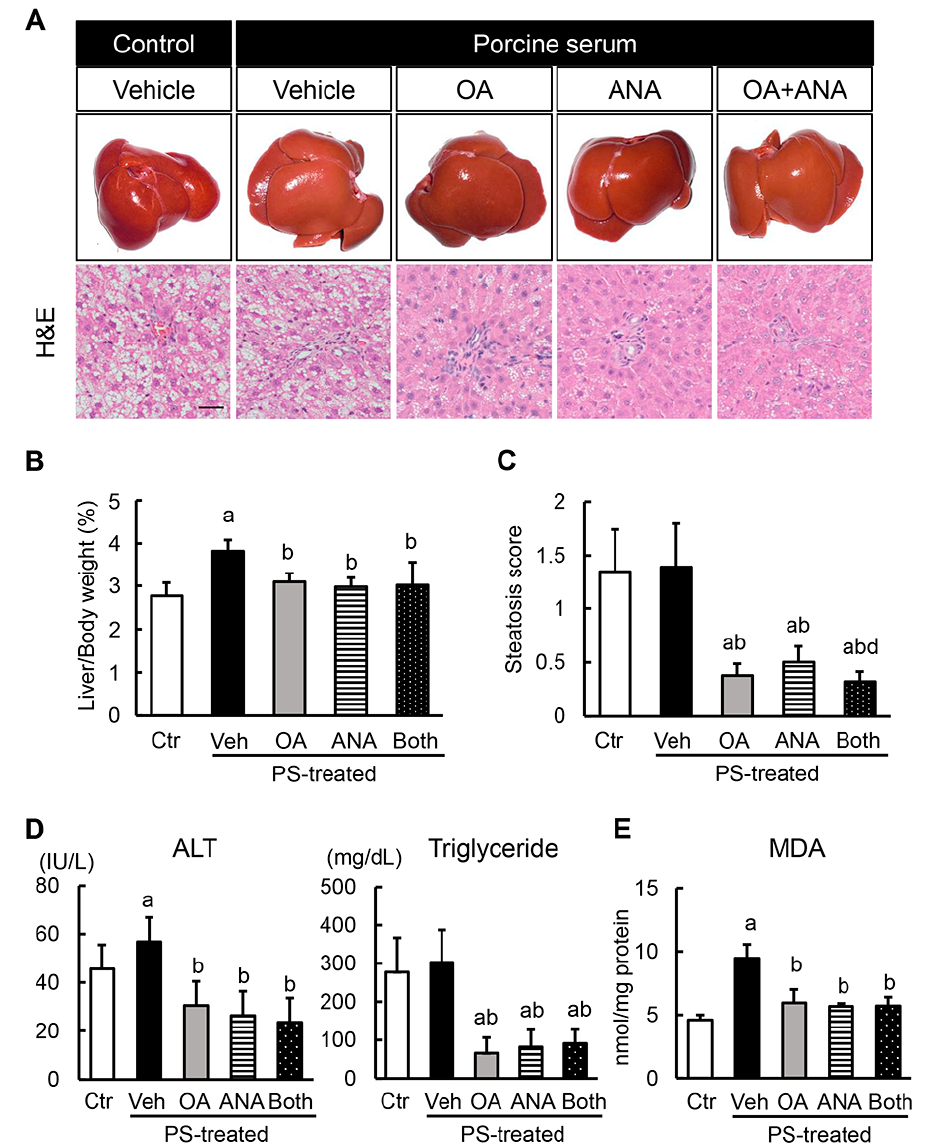
Figure 3. In vivo effects of oleanolic acid and anagliptin on hepatic steatosis and lipid peroxidation. ( A ) Representative macroscopic appearances (upper panels) and microphotographs of hematoxylin and eosin (HE) staining (lower panels) in the experimental groups. Scale bar; 50 µ m. ( B ) Ratio of liver to body weight. ( C ) Histological score of steatosis according to NAFLD Activity Score. ( D ) Serum levels of alanine aminotransferase (ALT) and triglyceride (TG). ( E ) Hepatic concentrations of malondialdehyde (MDA). Data are mean ± SD ( n = 10). Ctr; negative control group, Veh; vehicle-treated PS-injected group, OA; oleanolic acid-treated PS-injected group, ANA; anagliptin-treated PS-injected group, Both; oleanolic acid and anagliptin-treated PS-injected group. a , P ≤ 0.05 compared with Ctr-group; b , P ≤ 0.05 compared with Veh-group; c , P ≤ 0.05 compared with OA-group; d , P ≤ 0.05 compared with